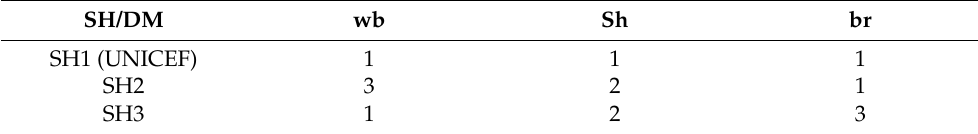
Table 4. Weight matrix for three stakeholders/decision makers to evaluate child well-being. SH/DM wb Sh